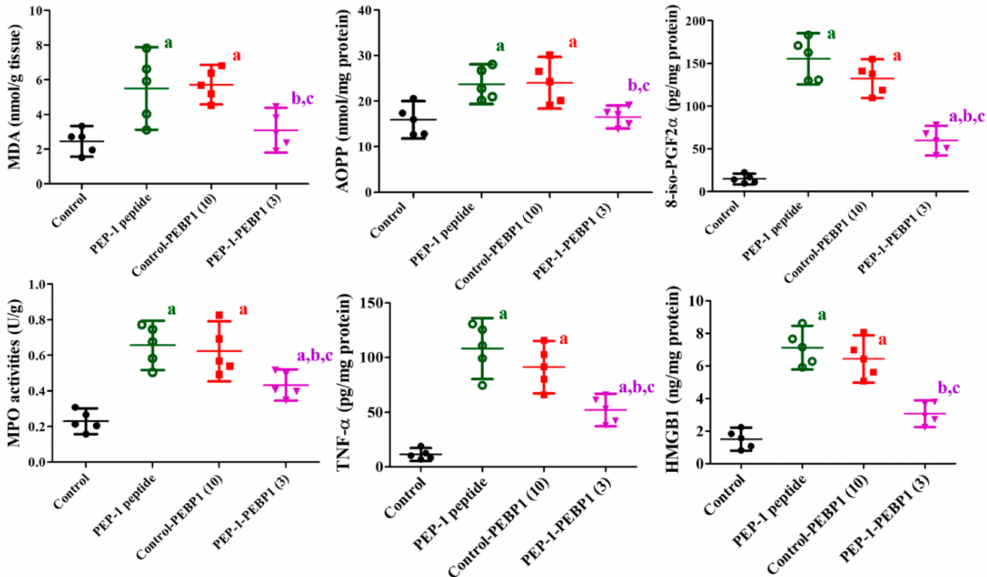
Figure 6. E ff ects of Control-PEBP or PEP-1-PEBP1 on MDA, AOPP, 8-iso-PGF2 α , MPO, TNF- α , and HMGB in the spinal cord 72 h after ischemia / reperfusion ( n = 5 per group; a p < 0.05, significantly di ff erent from the control group, b p < 0.05, significantly di ff erent from the PEP-1 peptide-treated group, c p < 0.05, significantly di ff erent from the control-PEBP1-treated group). The bars indicate confidence